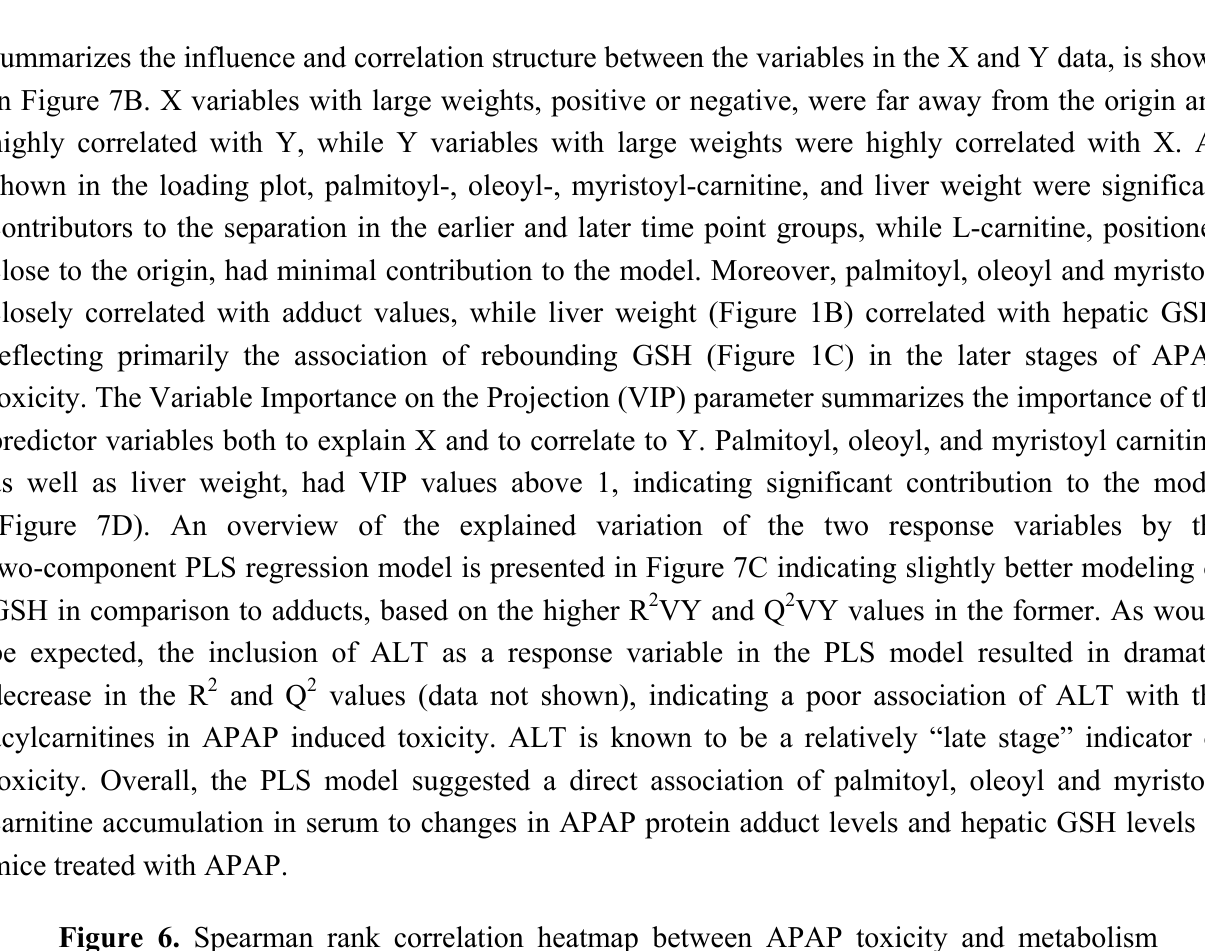
Figure 6. Spearman rank correlation heatmap between APAP toxicity and metabolism parameters and the acylcarnitines. Statistically significant correlations (p value < 0.05) are shown in blue (positive correlation) and red (negative correlation) color scale. Insignificant correlations are left blank. The larger the circle is the stronger is the